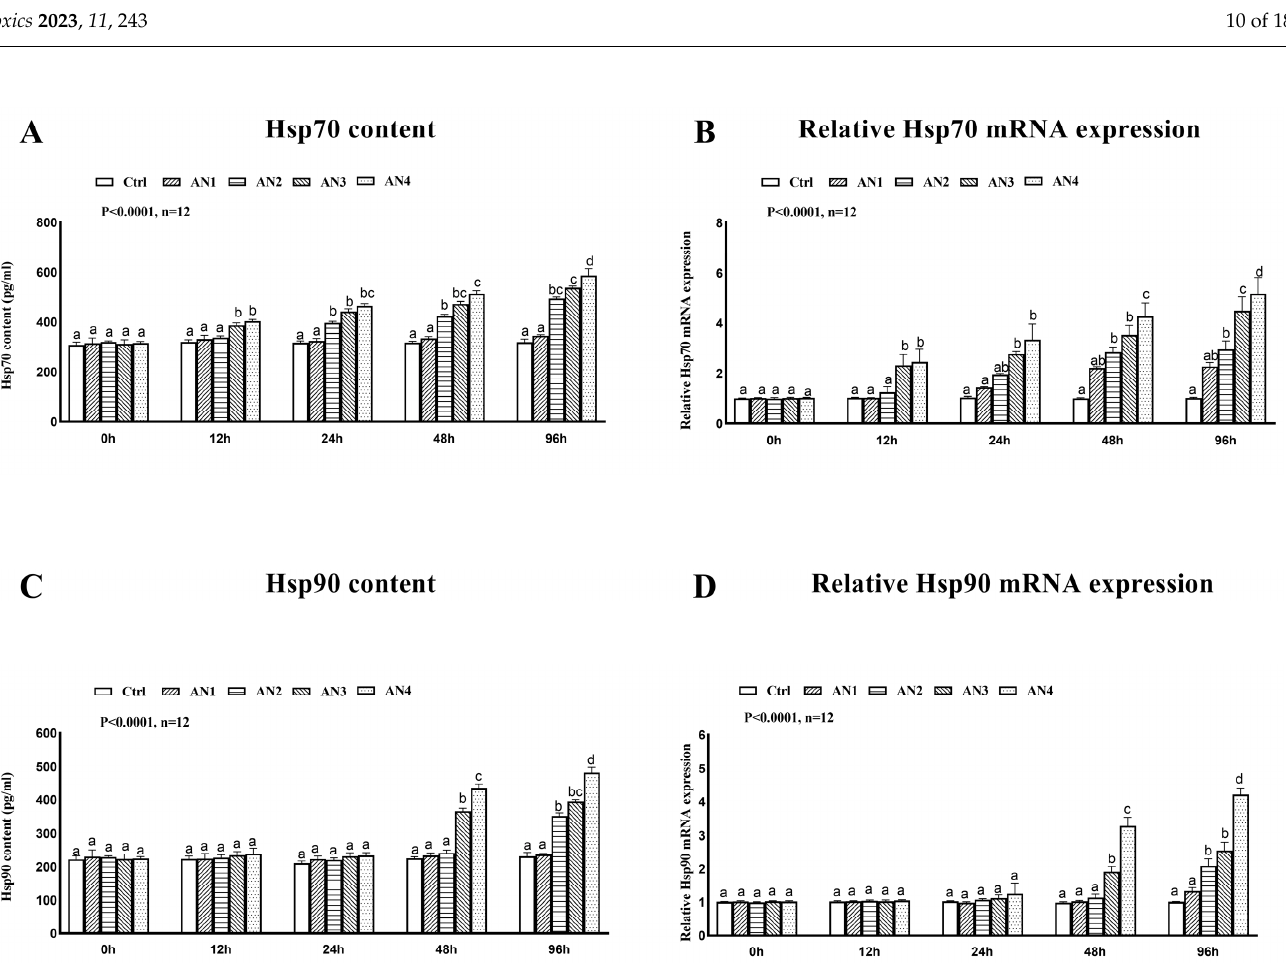
Figure 6. Changes of heat shock protein content and gene expression of bighead carp exposed to ammonia. ( A ) Heat shock protein 70 (HSP70), ( B ) relative Hsp70 mRNA expression, ( C ) heat shock protein 90 (HSP90), and ( D ) relative Hsp90 mRNA expression. Values are expressed as mean ± standard error (SE) from triplicate groups ( n = 12). Bars with different letters (a, b, c, d) differ significantly from those of other groups ( p < 0.05).